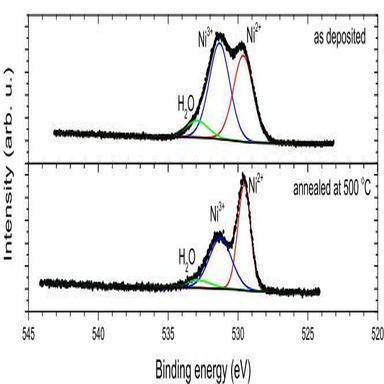
XPS spectra due to O 1s for a 1700-nm-thick NiO film (Sample 1) in asdeposited state and after annealing at the shown temperature. Symbols indicate experimental data, which were fitted to Gauss–Lorentzian curves (colored) assigned to the stated species. Intensity (arbitrary units) is shown on the ordinate axis. (For interpretation of the references to color in this figure legend, the reader is referred to the Web version of this article.)